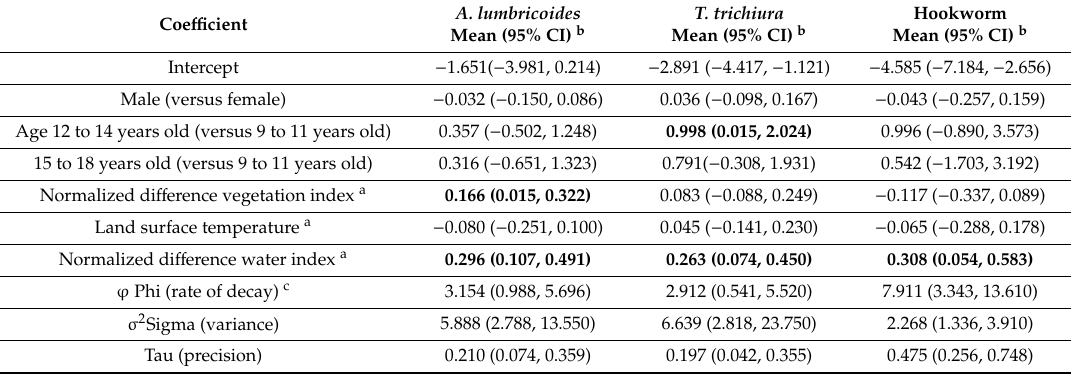
Table 3. E ff ects from geostatistical models estimating prevalence of A. lumbricodes , T. trichiura and hookworm in Rwanda in 2014. Bolded text displays statistically significant